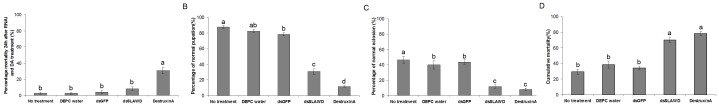
Phenotypic analysis of S. litura after RNAi and DA treatment.A: Percentage mortality 24 h after RNAi or DA treatment; B: Percentage of normal pupation; C: Percentage of normal eclosion; D: Cumulative mortality of S. litura. The different letters above the columns indicate significant differences in SLAWD expression after RNAi or DA treatment (P<0.05).